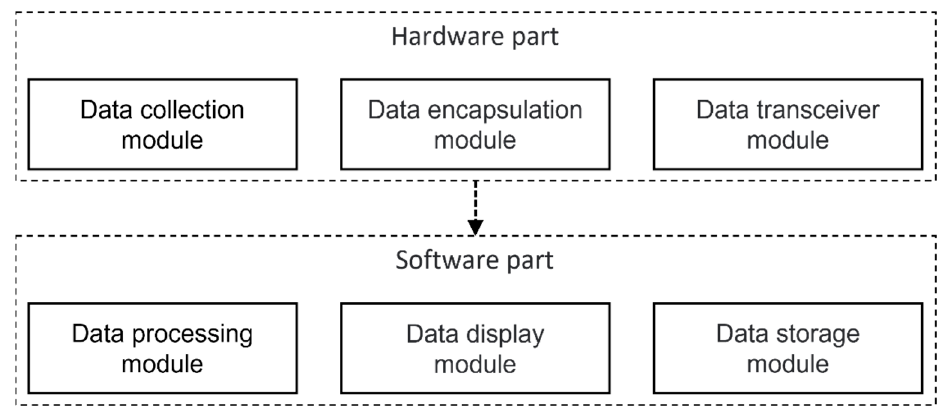
Figure 4. Collection system design.